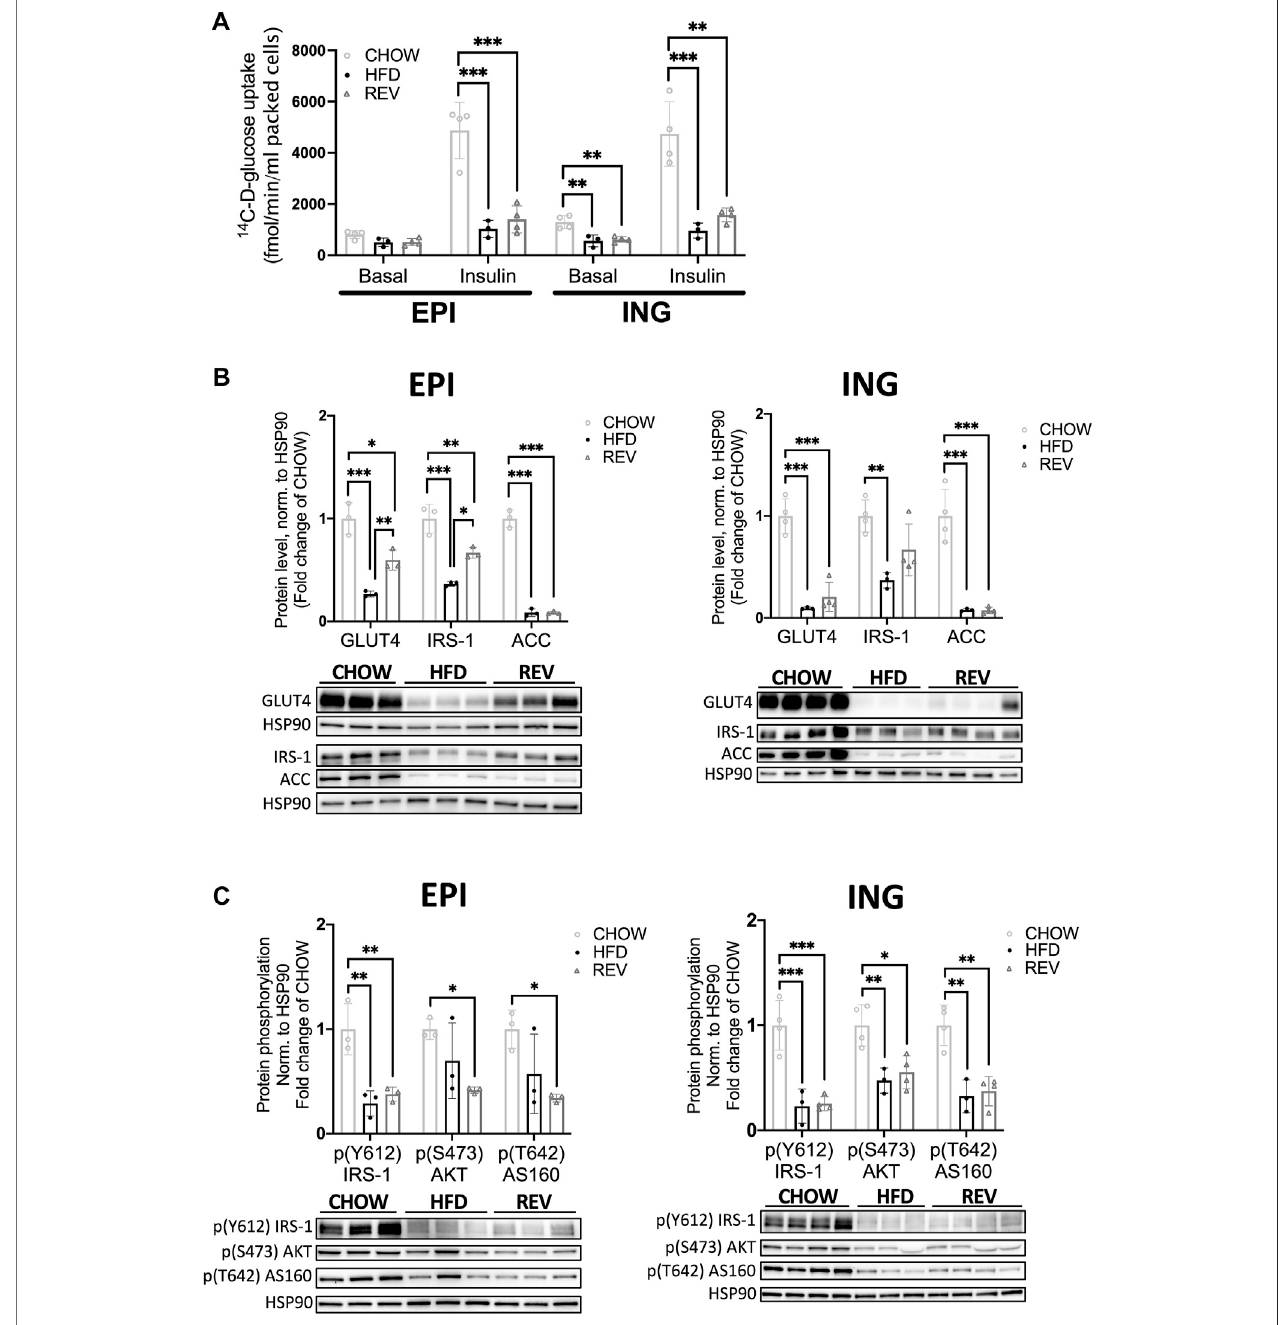
FIGURE6| Insulin-stimulatedglucoseuptakeinprimaryadipocytesfollowing12 weeksofdietintervention. (A) Non(basal)andinsulinstimulatedglucoseuptakein primary adipocytes isolated from EPI or ING fat depot following 12-week diet-intervention of CHOW, HFD and REV. In short, adipocytes were isolated and then non- stimulated (basal) or stimulated with insulin (10 nM) for 30 min before adding a glucose-tracer for additional 30 min incubation. Glucose uptake is expressed as femtomole glucose uptake per min per ml packed cells. n = 3 – 4/condition. (B) Western blot analysis from 12-week diet-intervention and corresponding quanti fi cation of GLUT4, IRS-1 and ACC from isolated EPI (left panel) and ING (right panel) adipocytes. (C) Western blot analysis from 12-week diet-intervention and corresponding quanti fi cation of phosphorylation of IRS-1 (Y612), AKT (S473) and AS160 (T642) from non-stimulated (basal) EPI (left panel) and ING (right panel) adipocytes.ValuesareexpressedasfoldofCHOWandHSP90wasusedasaloadingcontrol.Dataaredisplayedasmean±SDandone-wayANOVA,Tukey ’ spost-hoc test, was used as statistical analysis. Signi fi cance was determined according to * p ≤ 0.05, ** p ≤ 0.01 and *** p ≤ 0.001.